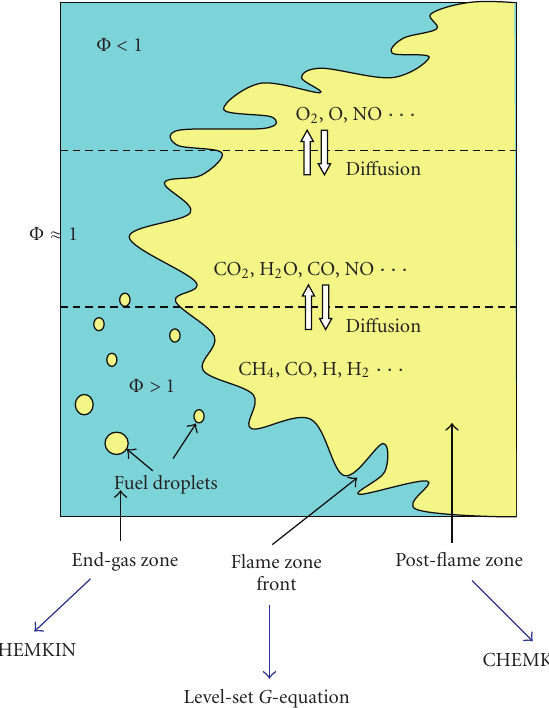
Figure 2: GAMUT combustion model for partially premixed